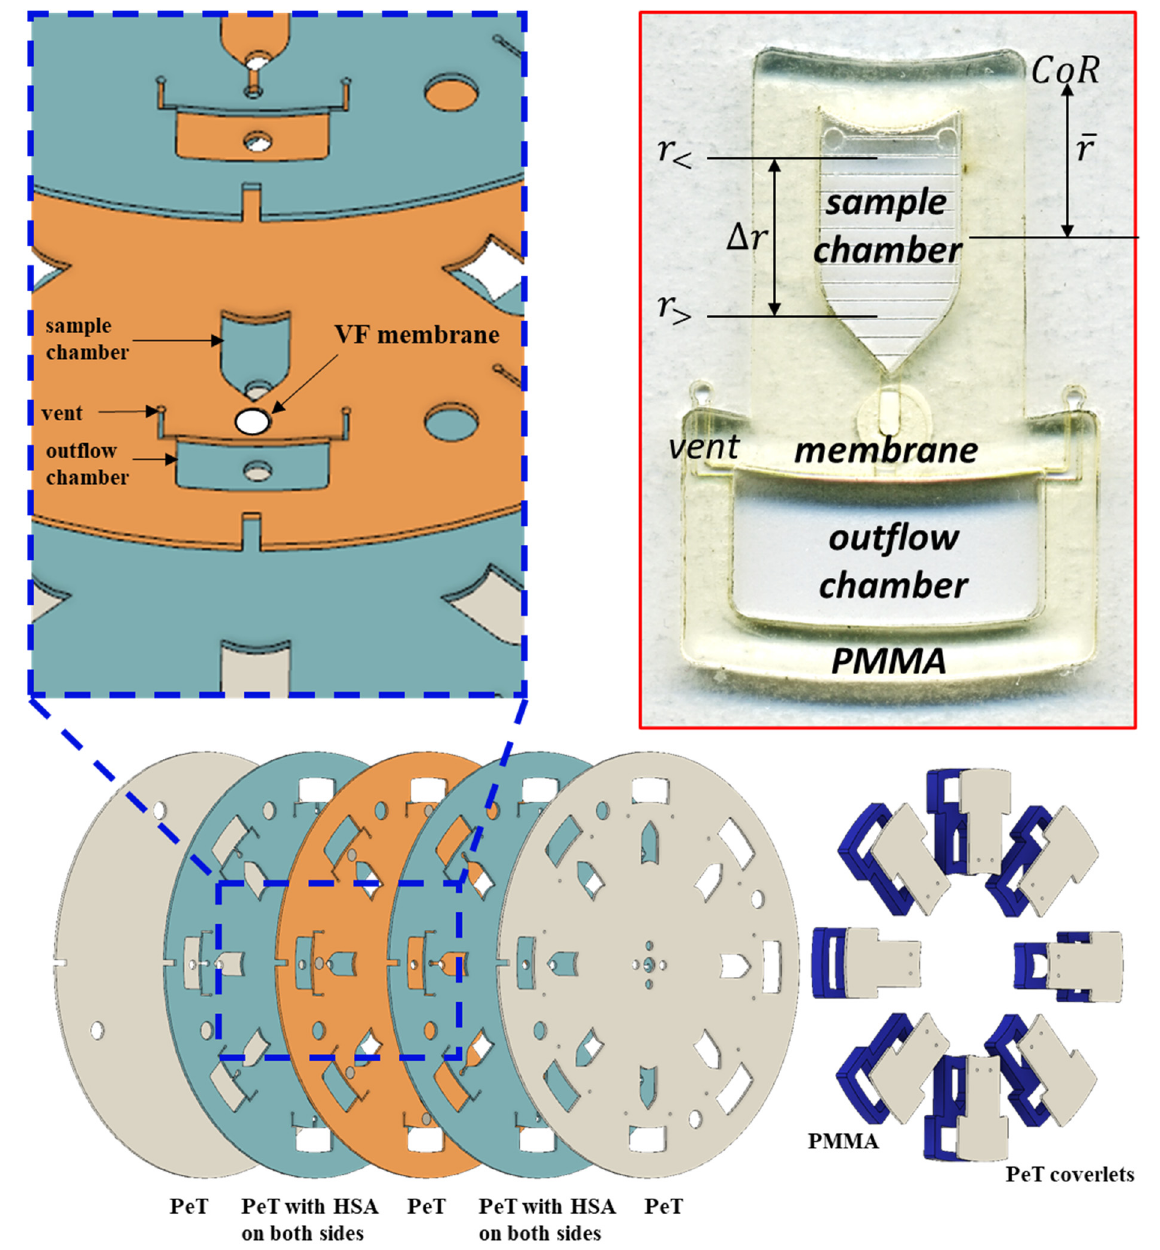
Figure 1. Schematic overview of a the putative cOF disc and a photograph of a single test domain on a fully assembled cOF disc. Diagrammatic exploded view of a six-layer (5 + 1) microfluidic disc design comprised of one polymethyl methacrylate (PMMA) layer and five polyethylene terephthalate (PET) layers. Layers 2 and 4 serve as the primary fluidic layers. Layer 3 functions a flow through or via layer. Circular cutouts (4- or 5-mm Ø) of porous membranes were placed into cutout recesses in layer 3. Upon lamination, HSA coated layers 2 and 4 bond to the membrane, anchoring it in place.